Question: Identify the chart type used in this figure.
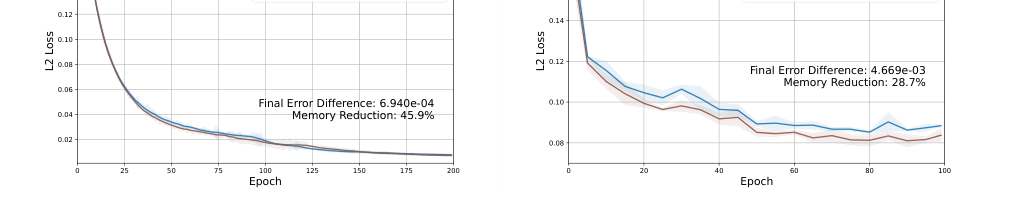
Answer: bar